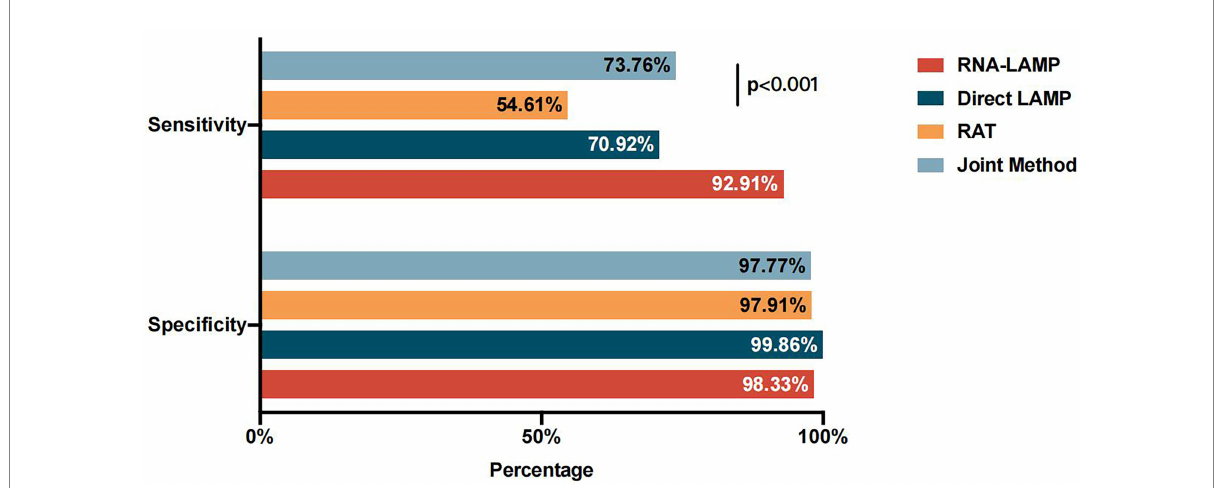
FIGURE 5 Diagnostic performance of the RNA-LAMP assay, direct LAMP assay, RAT, and joint